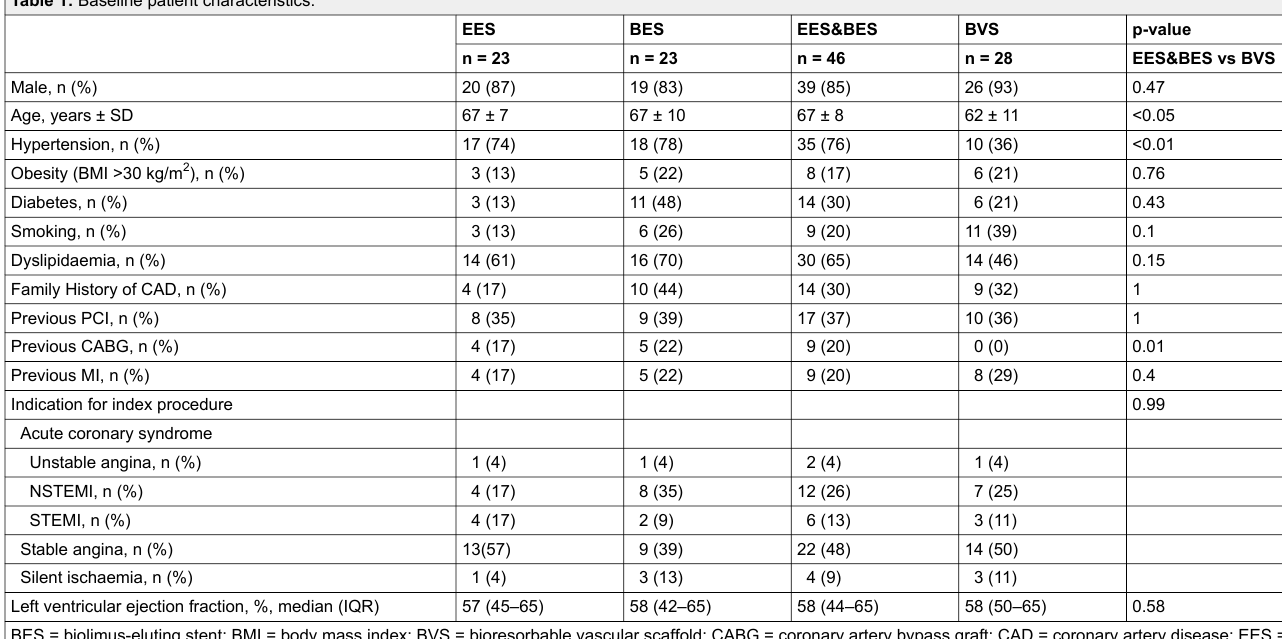
Table 1: Baseline patient